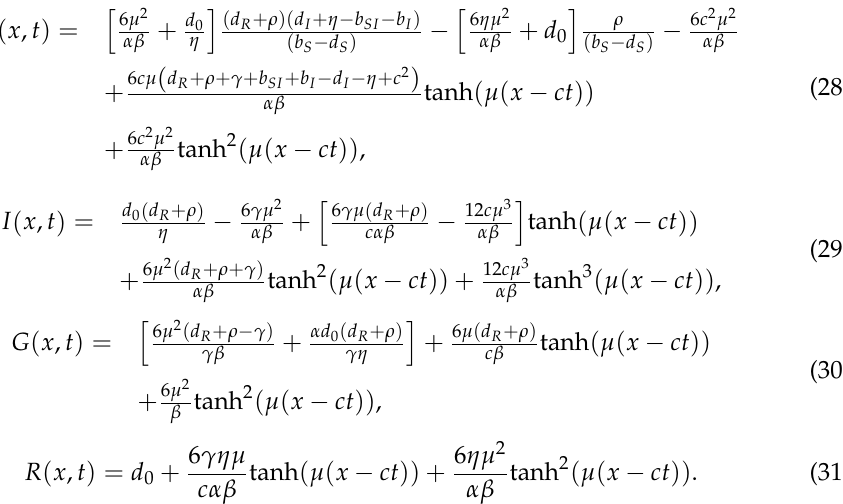
Figure 2 shows the plots of the wave fronts of the susceptible population S ( x , t ) in Figure 2a, the infected population I ( x , t ) in Figure 2b, and the recovered population R ( x , t ) in Figure 2c, given in (28), (29) and (31), respectively. Here a 0 = 1.1345, a 1 = 0.5355, a 2 = 0.00675, b 0 = 0.9625, b 1 = 1.24775, b 2 = 0.075, b 3 = 0.00225, c 0 = 0.8, c 1 = 1, c 2 = 0.03, d 0 = 0.4, d 1 = 0.5, and d 2 = 0.015. All parametric values have been chosen to satisfy inequalities (14)–(15) as well as Equations (15) and (26). We show the plots of proportions of susceptible, the infected and the recovered swine given by Equations (28), (29) and (31) as functions of radial distance x . The waves travel from left to right as time passes.